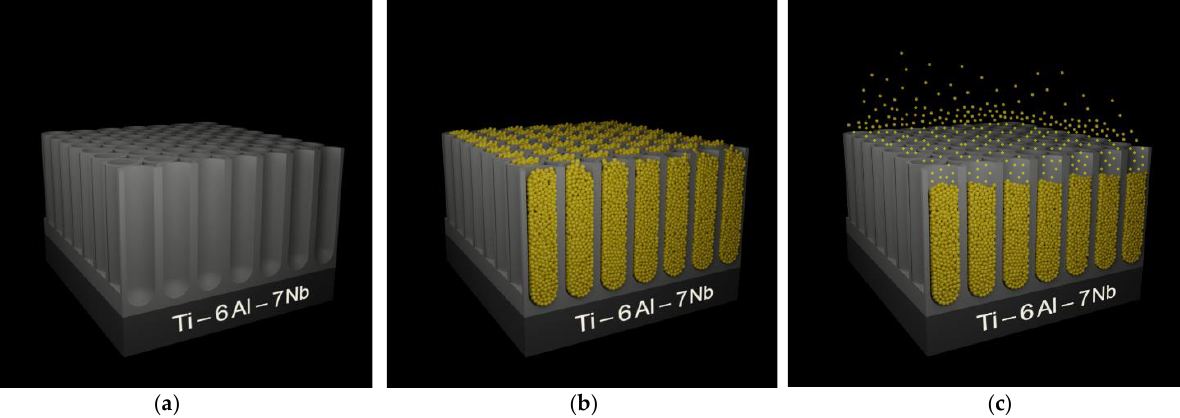
Figure 15. Scheme of oxide nanotubes (ONTs) on the Ti6 – Al – 7Nb alloy as a carrier of gentamicin sulfate (GS): ( a ) ONT layer after anodizing; ( b ) ONT layer loaded with GS; ( c ) release of GS molecules from ONTs immersed in phosphate-buffered solution. GS molecules are marked as yellow spheres.